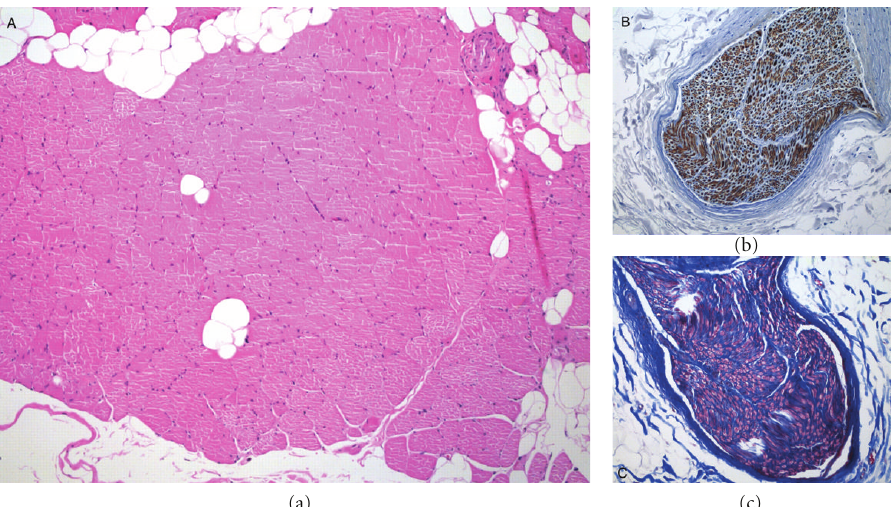
Figure 1: Histology of excised innervated flap (gracilis) after 14 months. (a) Muscle fibres show no features of denervation atrophy, Haematoxylin and Eosin 100x. (b) Nerve section shows normal fasciculi without reactive axons and normal axonal density, APP Immunohistochemistry 200x. (c) Nerve section shows well preserved myelinated fibers axons with normal density, Masson stain 200x.